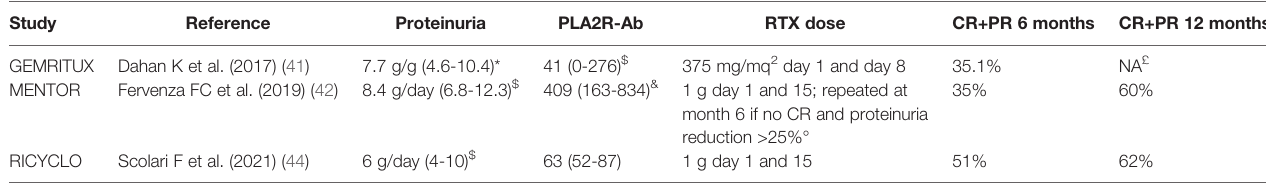
TABLE 2 | Main baseline characteristics, therapeutic schedule and response rates in the rituximab arms of randomized control studies exploring rituximab effectiveness in primary membranous